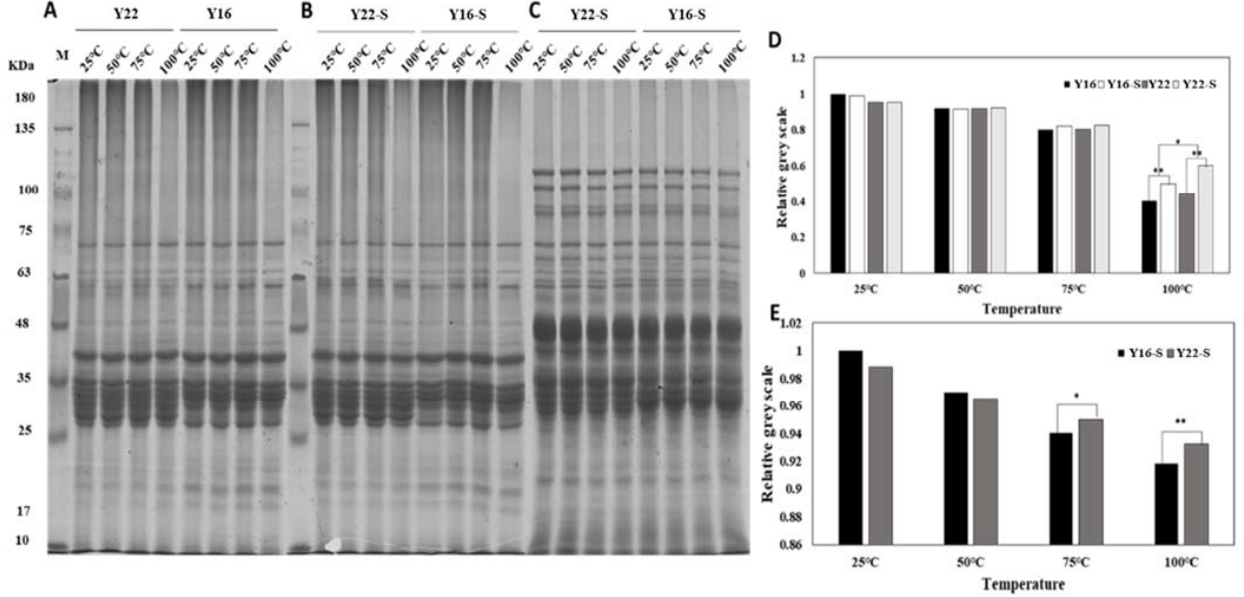
Figure 3. SDS ‐ PAGE patterns and grey ‐ scale measurements in different glutens and gluten–starch Figure 3. SDS-PAGE patterns and grey-scale measurements in different glutens and gluten–starch mixtures during heating. ( A , B ) Non ‐ reducing SDS ‐ PAGE patterns of Y22 and Y16, Y22 ‐ S and Y16 ‐ S mixtures during heating. ( A , B ) Non-reducing SDS-PAGE patterns of Y22 and Y16, Y22-S and Y16-S mixtures during heating, respectively; ( C ) reducing SDS ‐ PAGE pattern of Y22 ‐ S and Y16 ‐ S mixture mixtures during heating, respectively; ( C ) reducing SDS-PAGE pattern of Y22-S and Y16-S mixture during heating; ( D ) relative grey ‐ scale measurements for SDS ‐ soluble protein (130–200 KDa) from during heating; ( D ) relative grey-scale measurements for SDS-soluble protein (130–200 KDa) from ( A , B ); ( E ) relative grey ‐ scale measurements for HMW ‐ GS from ( C ). * and ** indicate significant level ( A , B ); ( E ) relative grey-scale measurements for HMW-GS from ( C ). * and ** indicate significant level of 5% and 1%, respectively. of 5% and 1%, respectively.